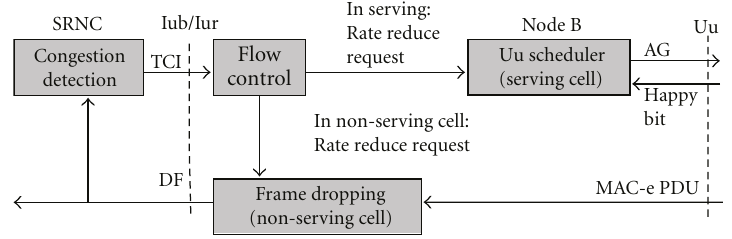
Figure 4: Flow control